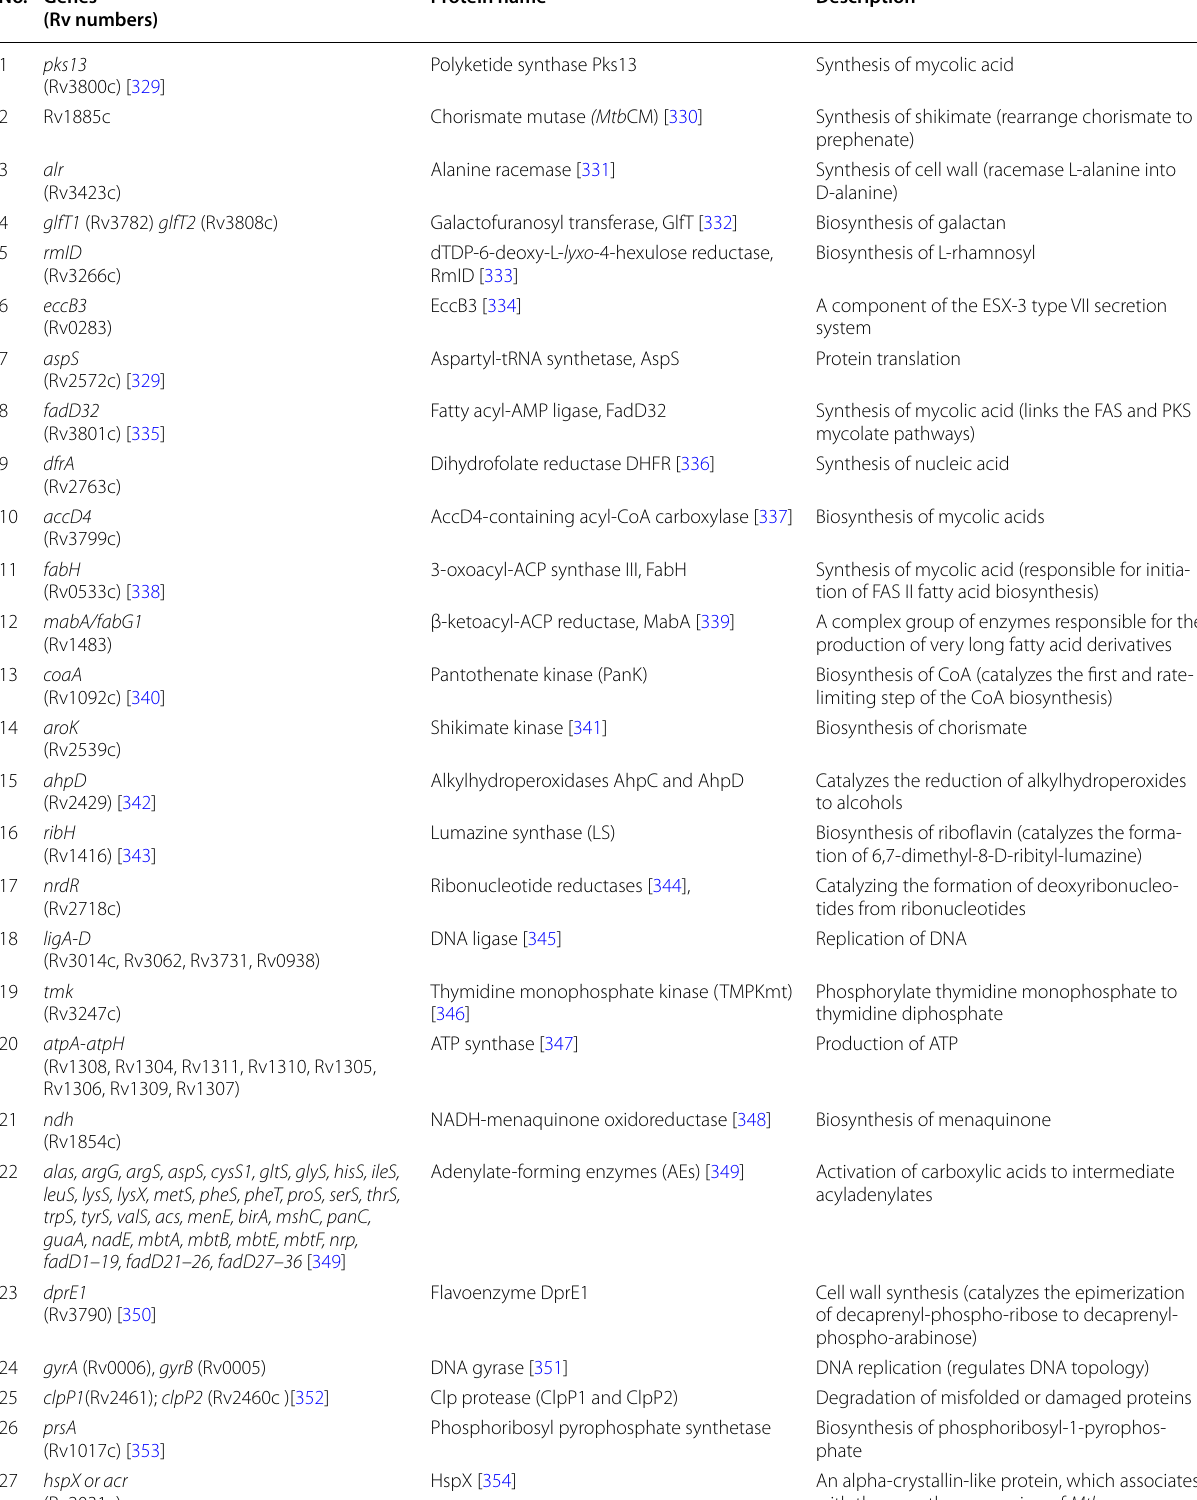
Table 2 Overview of potential targets of anti-tuberculosis agents No. Genes (Rv